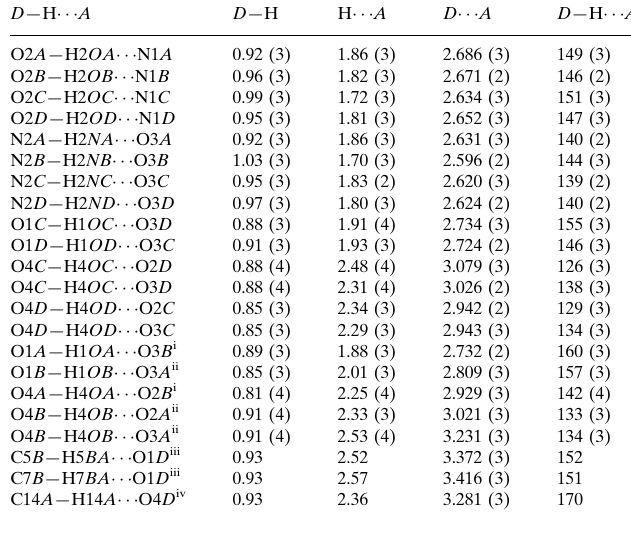
Hydrogen-bond geometry (A˚ , (cid:2)